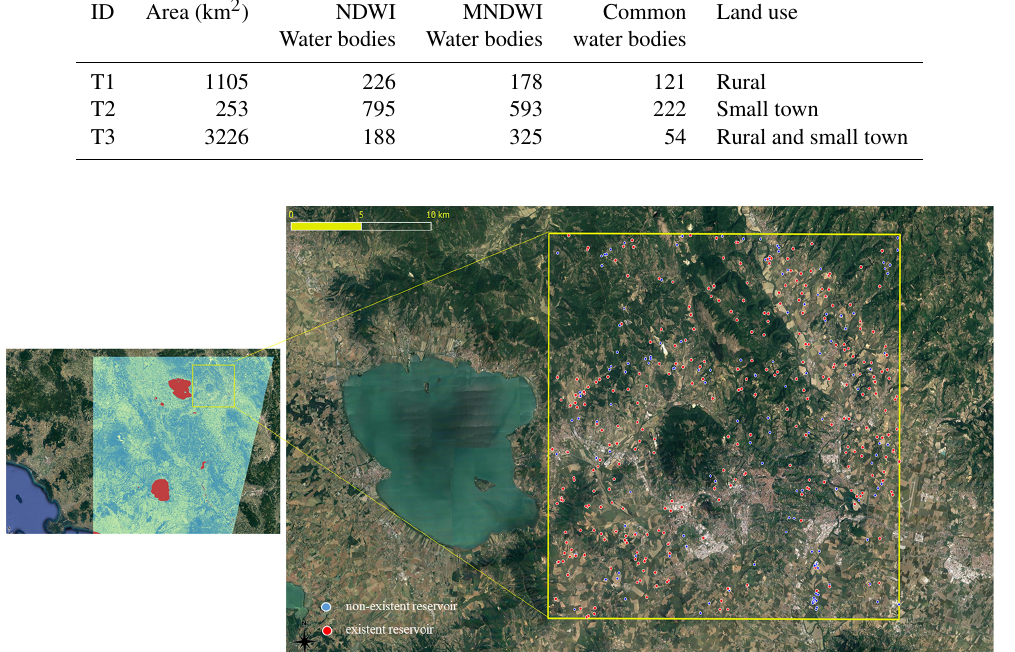
Figure 8. Test area selected for the NDWI–database comparison. ©Google Map source: Immagini©2018 TerraMetrics, Dati Car- tografici©2018.